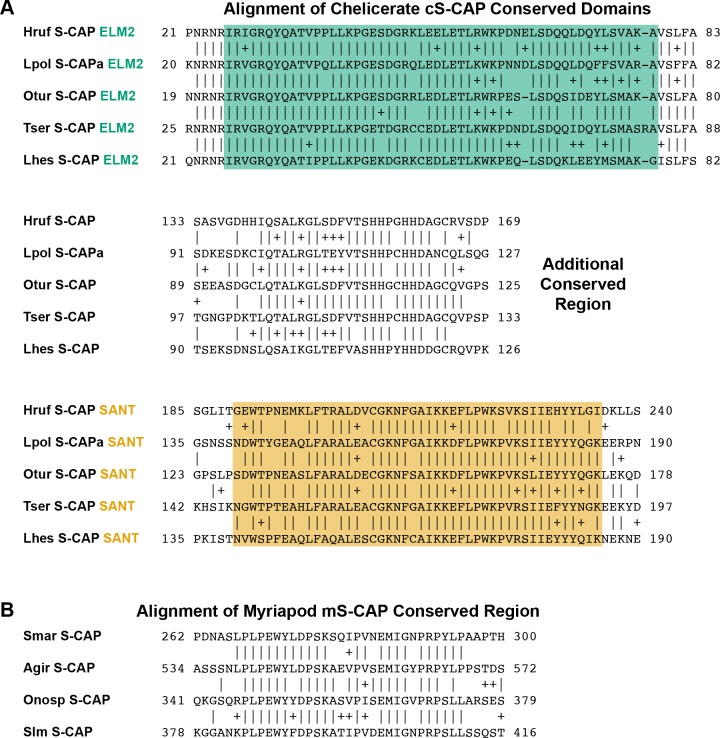
Alignments of sequence regions shared by representative S-CAP proteins from (A) Chelicerates and (B) Myriapods.Amino acids at the ends of the aligned sequences are numbered. Pairwise amino acid sequence identities are indicated by vertical lines; conservative substitutions are indicated by + signs. ELM2 and SANT domains found in Chelicerate S-CAPs (A) are highlighted in colors corresponding to those in Figure 5B. Species names are as follows: (A) Hruf (Hypochthonius rufulus), Lpol (Limulus polyphemus), Otur (Ornithodoros turicata) (Egekwu et al., 2016), Tser (Tityus serrulatus) (Fuzita et al., 2015), Lhes (Latrodectus hesperus) (Clarke et al., 2015); (B) Smar (Strigamia maritima), Agir (Anopsobius giribeti), Onosp (Onomeris sp.), Slm (Sigmoria latior munda).